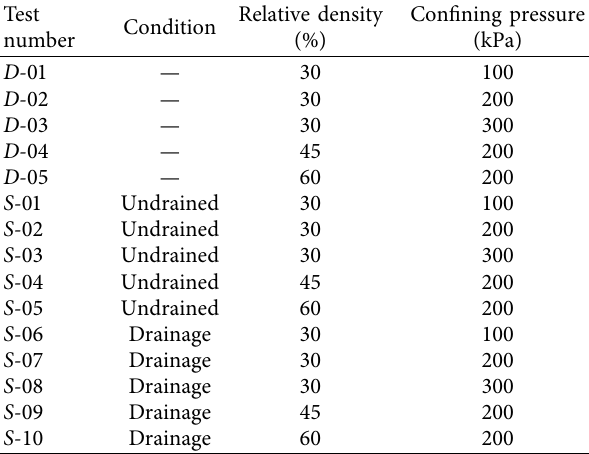
Table 2: Scheme of the monotonic triaxial tests.